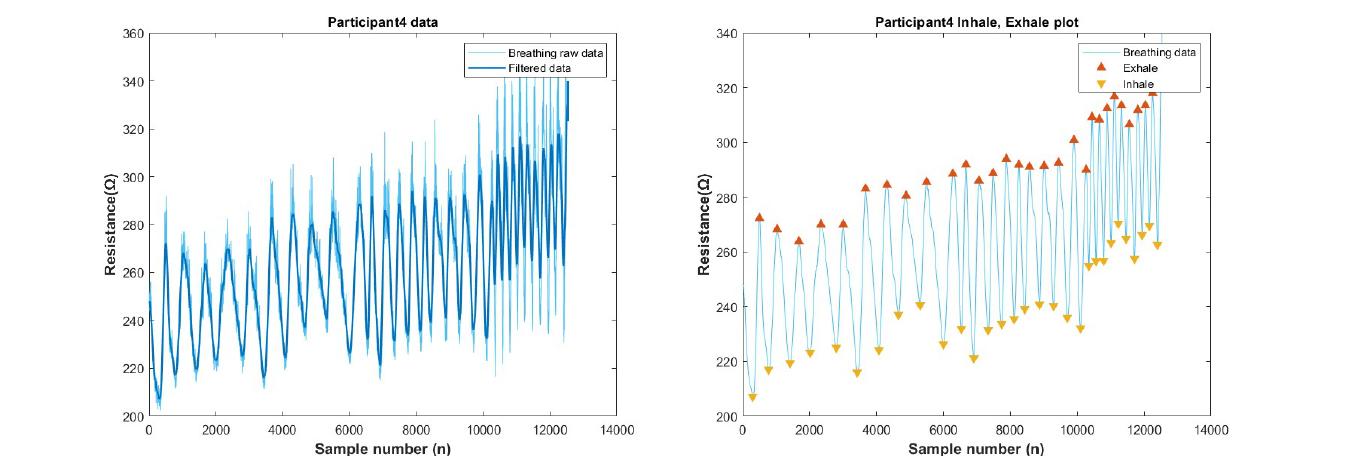
Figure A18. Breathing Test data of Participant number-3.